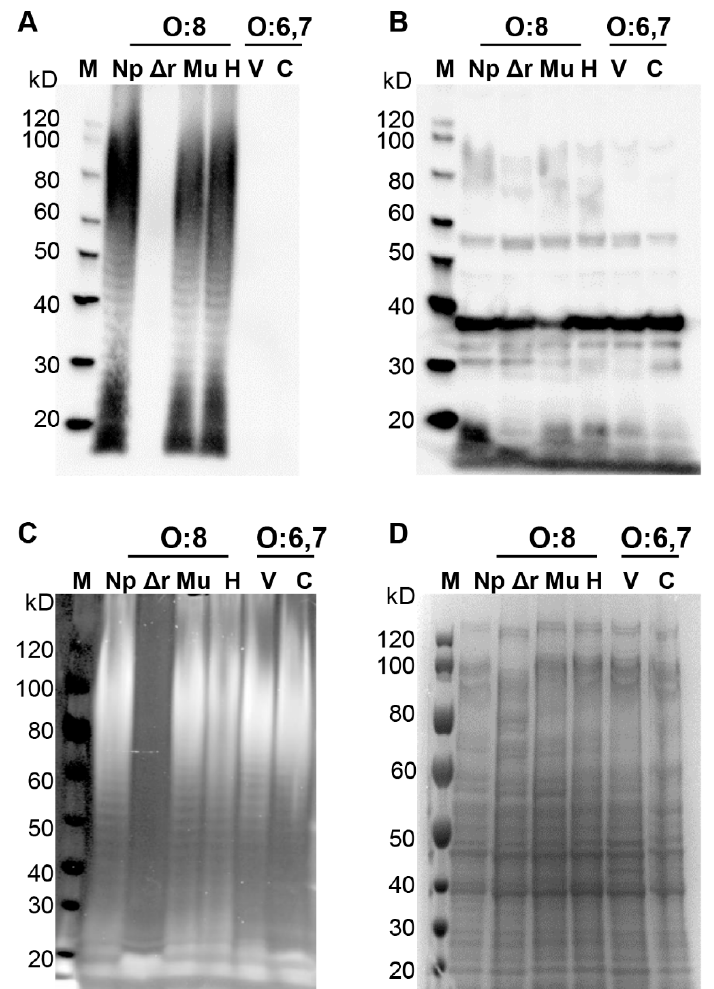
Figure 3. Specificity of antibodies elicited by live attenuated S . Newport CVD 1979 vaccine to Lipopolysaccharide (LPS) and whole cell lysates of Salmonella strains. LPS and whole cell lysates were extracted from group O:6,7 (C 1 ) and O:8 (C 2 -C 3 ) serovars. Overnight cultures of S . Virchow Q23 (O:6,7), S . Choleraesuis var Kunzendorf (O:6,7), S . Newport Chile 361 (O:8), S . Muenchen ATCC